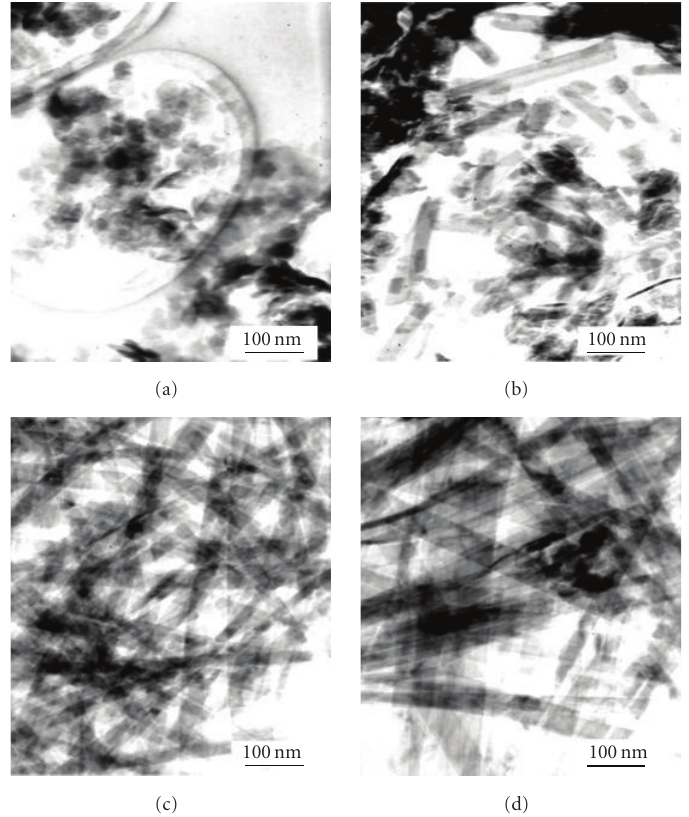
Figure 6: TEM images for Ni/Al LDHs with di ff erent reaction times, (a) 2 h; (b) 6h; (c) 12 h; (d) 18h.